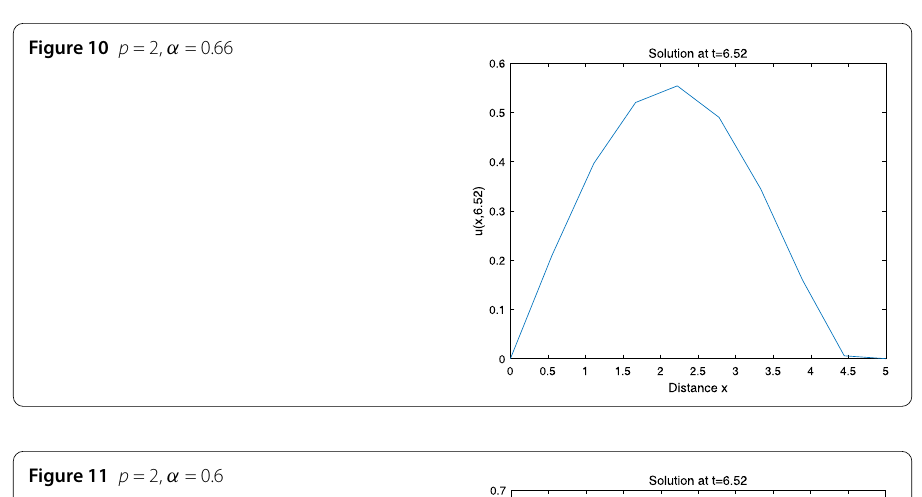
Figure 11 p = 2, α =